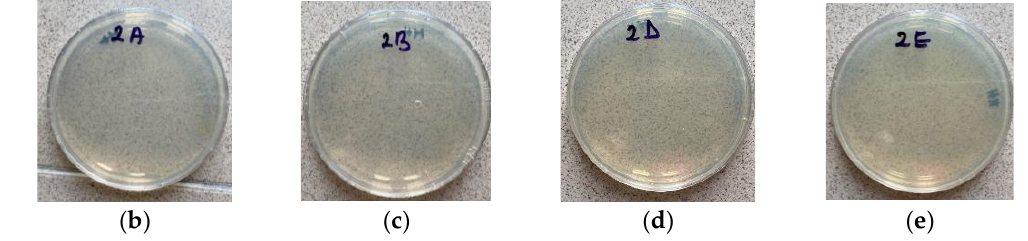
Figure 3. Microbial colonies after the disinfection with Zeta 7 Solution for each impression material: ( a ) Tropicalgin; ( b ) Zetaplus; ( c ) Oranwash L; ( d ) Elite HD + Putty Soft; ( e ) Elite HD + Light Body.